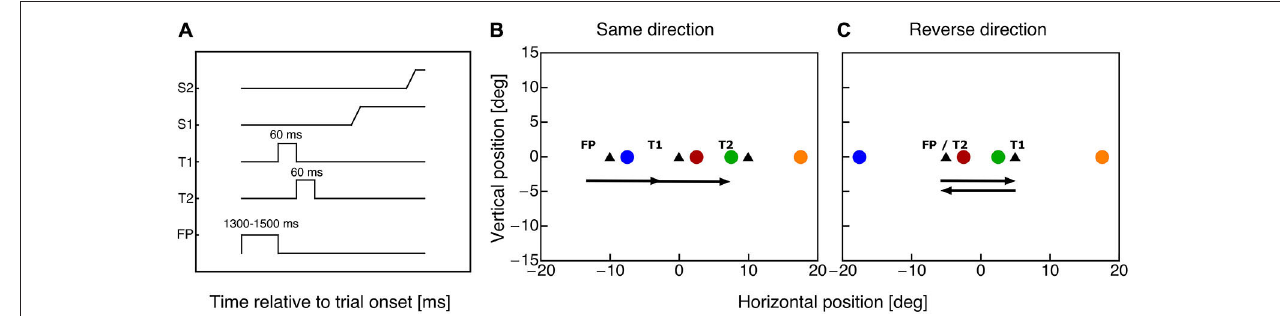
FIGURE 1 | (A) Timecourse of events in the double step task. The fixation point was shown for a variable time between 1300 and 1500 ms. With offset of the fixation point the first saccade target (T1) appeared for 60 ms. Simultaneously with the disappearance of target T1 saccade target T2 was presented for 60 ms. The subject performed two horizontal saccades (S1 and S2) to the remembered target positions. (B) Positions of fixation point and saccade targets (triangle symbols) in the same-direction double-step paradigm. The colored dots indicate the eight possible probe dot locations. Horizontal probe positions were: − 7.5 ◦ , 2.5 ◦ , 7.5 ◦ and 17.5 ◦ . (C) Positions of fixation point and saccade targets (triangle symbols) in the cross-direction double-step paradigm. The colored dots indicate the eight possible probe dot locations. Horizontal probe positions were: − 17.5 ◦ , − 2.5 ◦ , 2.5 ◦ and 17.5 ◦ .